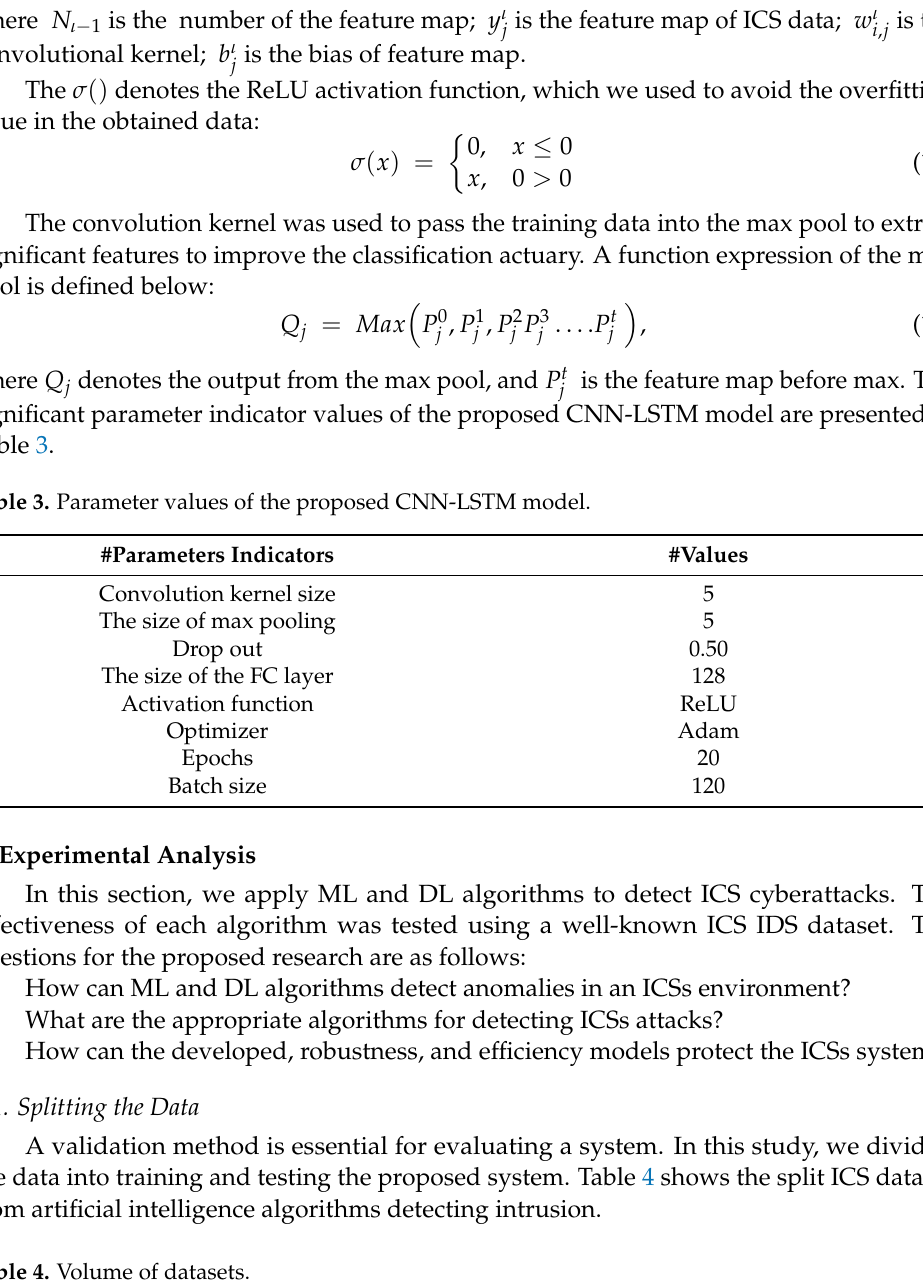
Table 4. Volume of